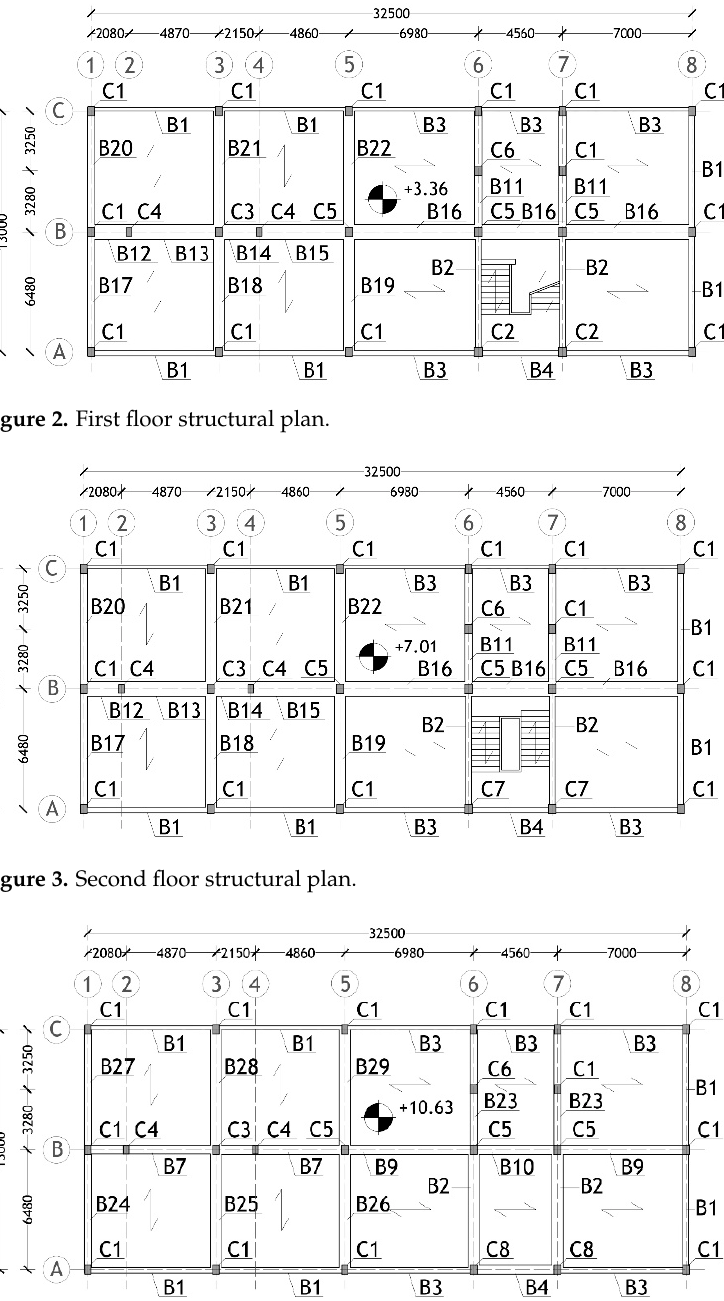
Figure 5. Roof structural plan. The structure of the storey floors is made of 280 mm-high and 80 mm-wide RC joists parallel to the transversal direction in plan in the two left frame spans, and parallel to the longitudinal direction in the three remaining frame spans. The joists are placed at a mutual distance of 700 mm, as determined by the interposed clay lug bricks, and a 40 mm thick upper RC slab. The roof floor structure is made of “SAPAL”-type 370 mm-high reinforced clay lug bricks, integrated by on-site cast 350 mm-high RC ribs placed at a mutual distance of 1250 mm, and a 50 mm thick upper RC slab. Foundations are constituted by a mesh of inverse T-beams, with heights and flanges ranging from 700 mm to 1000 mm, and from 600 mm to 800 mm, respectively. As part of the OSS (Seismic Observatory of Structures) programme promoted by the Italian Department of Civil Protection to structurally assess and monitor public buildings [51], a careful on-site mechanical investigation campaign was carried out on the case study one [52]. This campaign consisted of concrete cover demolitions (Figure 6a), pacometer tests (Figure 6b), and extraction of samples, for the reinforcing bars, and core drillings (Figure 7a) and Son-Reb tests (i.e., combined sclerometer—Figure 7b—and ultrasonic— Figure 7c—tests) for concrete. ( a ) ( b ) Figure 6. Images of a concrete cover demolition ( a ) and a pacometer test ( b ).